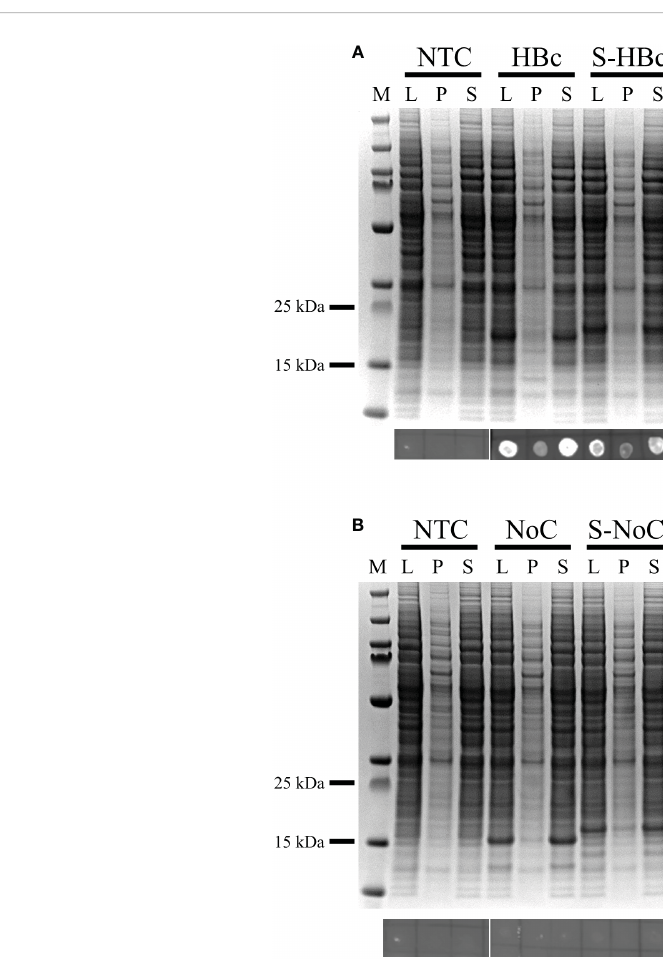
FIGURE 3 Expression and assembly analysis of the different HBc VLP constructs in BYL. SDS-PAGE (upper panels) and dot-blot (lower panels) results for the different HBc constructs after expression in BYL. For the dot blot, the conformational antibody 3120 was used, binding only to properly assembled particles (A) Expression and assembly analysis for the HBc constructs (B) Expression and assembly analysis for the NoC constructs. NTC, non-template control; HBc, hepatitis-B core antigen; L, lysate after reaction P, pellet fraction after lysate centrifugation S, supernatant fraction after lysate centrifugation; NoC, HBc core antigen lacking the C-terminal domain; S, Strep-tag II insert, located either at N-terminus (S-) or spike (-S) of the HBc and NoC